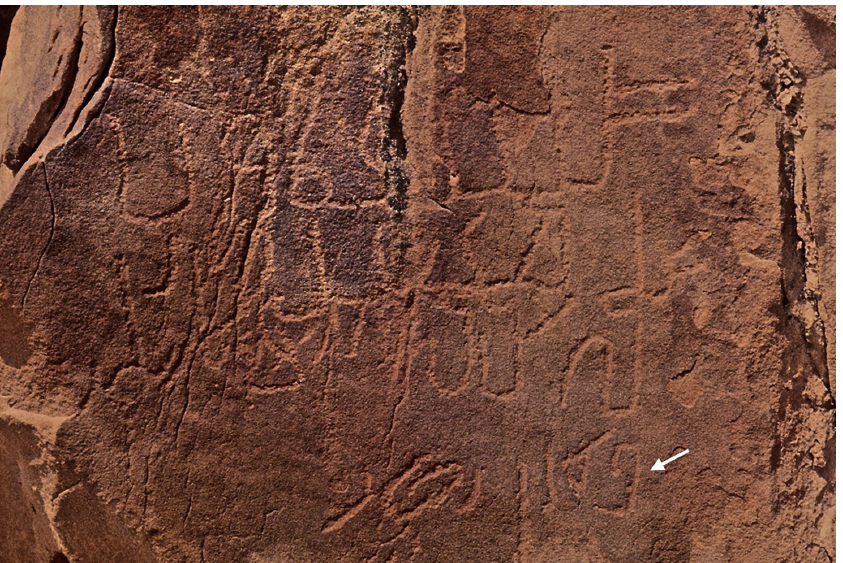
Figure 14 Two Nabataean inscriptions from Wadi Mukateb, southern Sinai, the lower bears the sur- name “Paran,” indicated by the arrow.